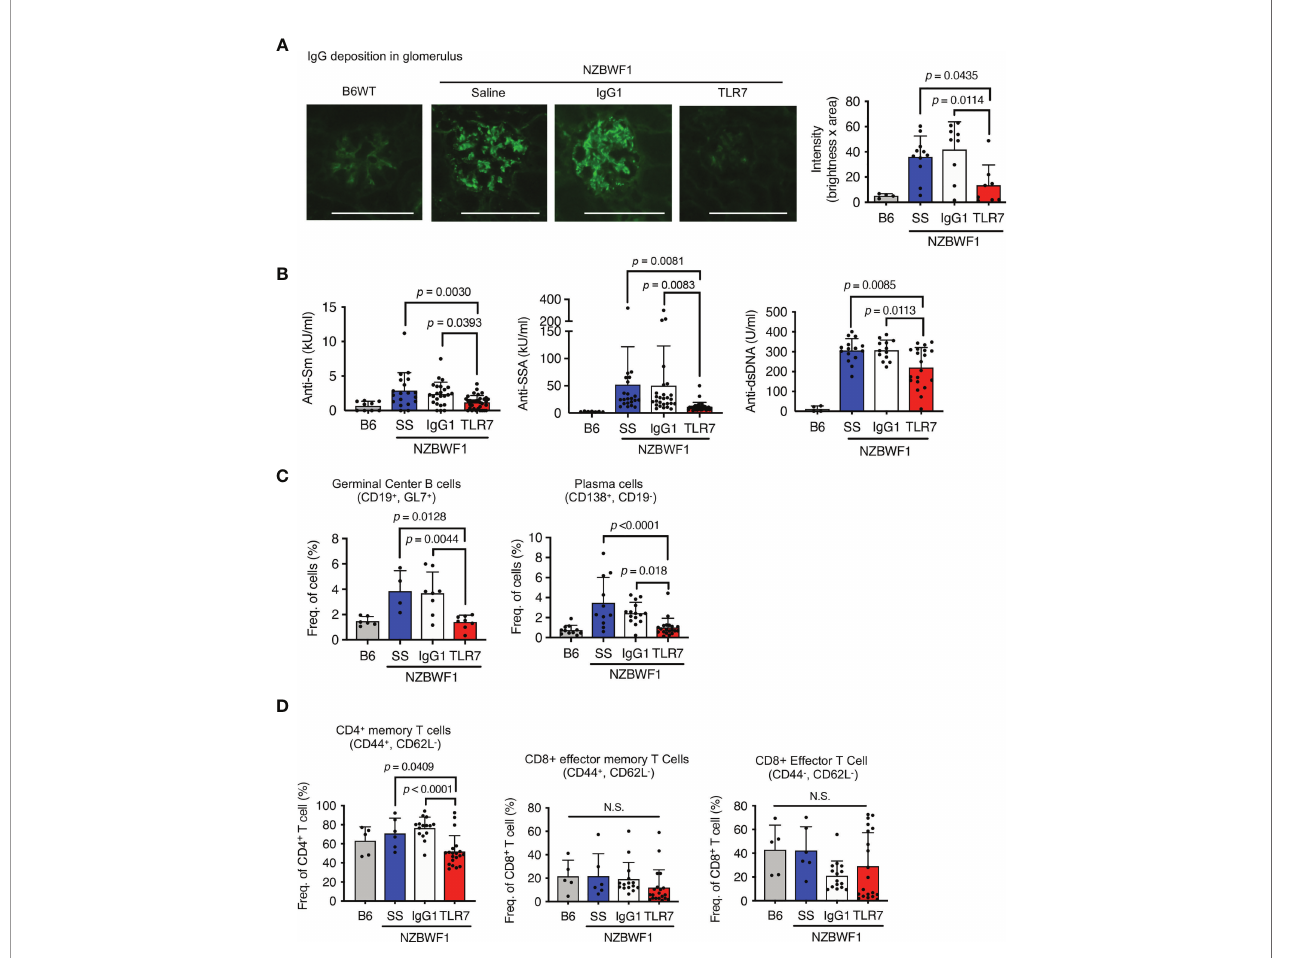
FIGURE 2 | Inhibition of IgG deposition in glomeruli and autoantibody production induced by anti-TLR7 mAb. (A – D) NZBWF1 mice were administered saline, IgG1 or anti-TLR7 mAb from ages of 12-16 to 35-40 weeks and compared with age-matched WT C57BL/6 (B6) mice. (A) Representative images of immunohistological staining with anti-IgG Ab (left). Scale bar, 100 m m. Quantitation of fl uorescence intensity in IgG-positive areas in glomeruli (right). Numbers of glomeruli assessed: B6 ( n = 4), saline ( n = 9), control IgG1 ( n = 9), and anti-TLR7 ( n = 7). (B) Serum levels of autoantibodies in mice aged 30-40 weeks. B6 ( n ≥ 4), saline ( n ≥ 15), control IgG1 ( n ≥ 13), and anti-TLR7 mAb ( n ≥ 20). (C, D) Ratios of B (C) and T (D) cell subsets in spleen. B6 ( n ≥ 4), saline ( n ≥ 4), control IgG1 ( n ≥ 8), and anti-TLR7 mAb ( n ≥ 8). Data were statistically analyzed using one-way ANOVA with Tukey ’ s multiple comparison tests. N.S., not signi fi cant. Data are shown as individual points and as means ± SD for each experimental